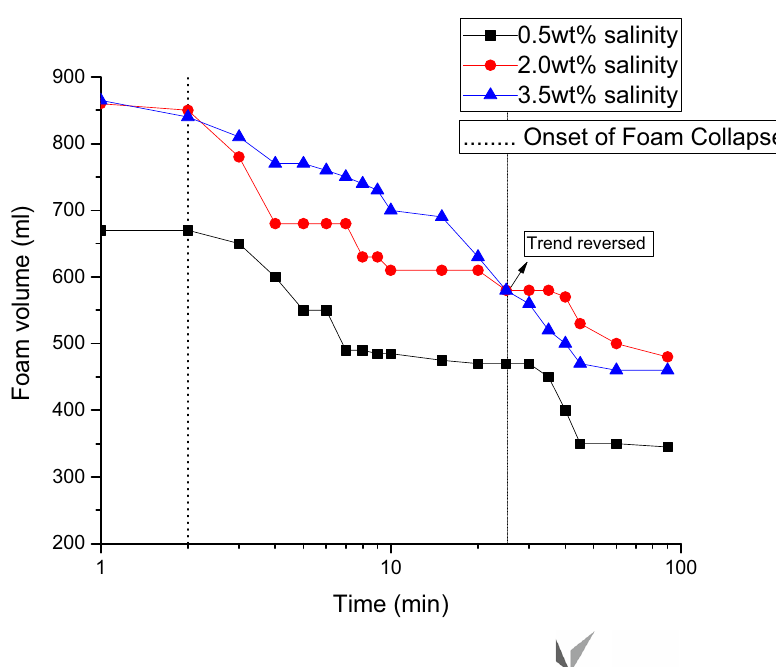
Fig. 5 Determination of salinity effect by using the modified bulk foam stability